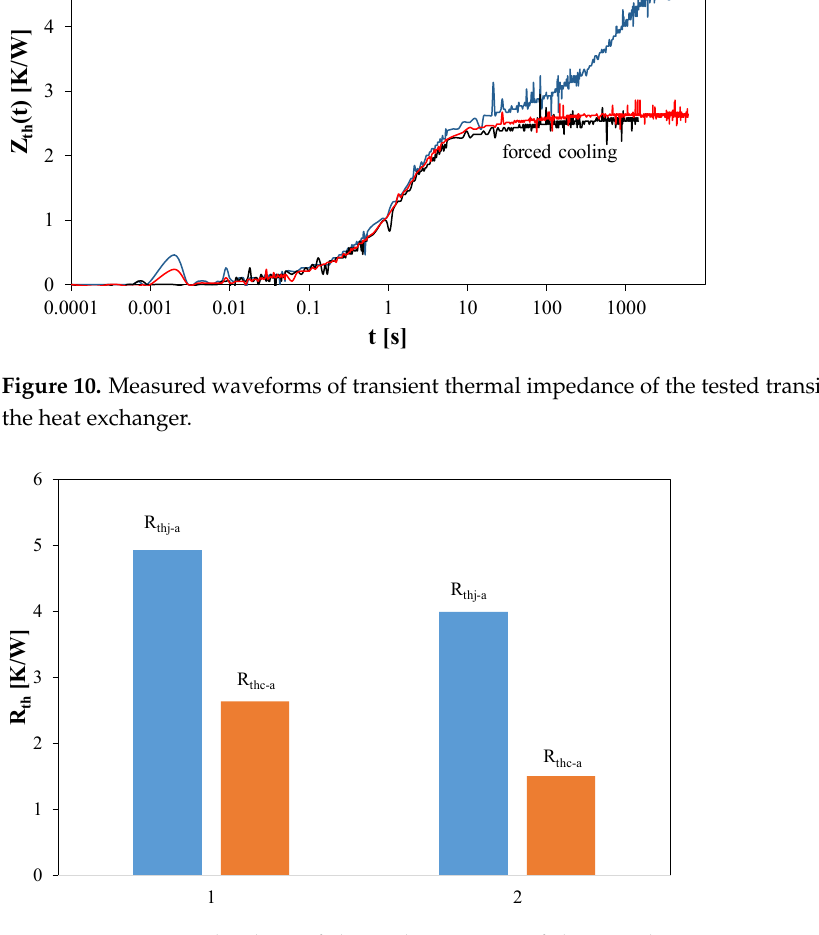
Figure 11. Measured values of thermal resistance of the tested transistor mounted on the heat exchanger with free (1) and forced (2) cooling.